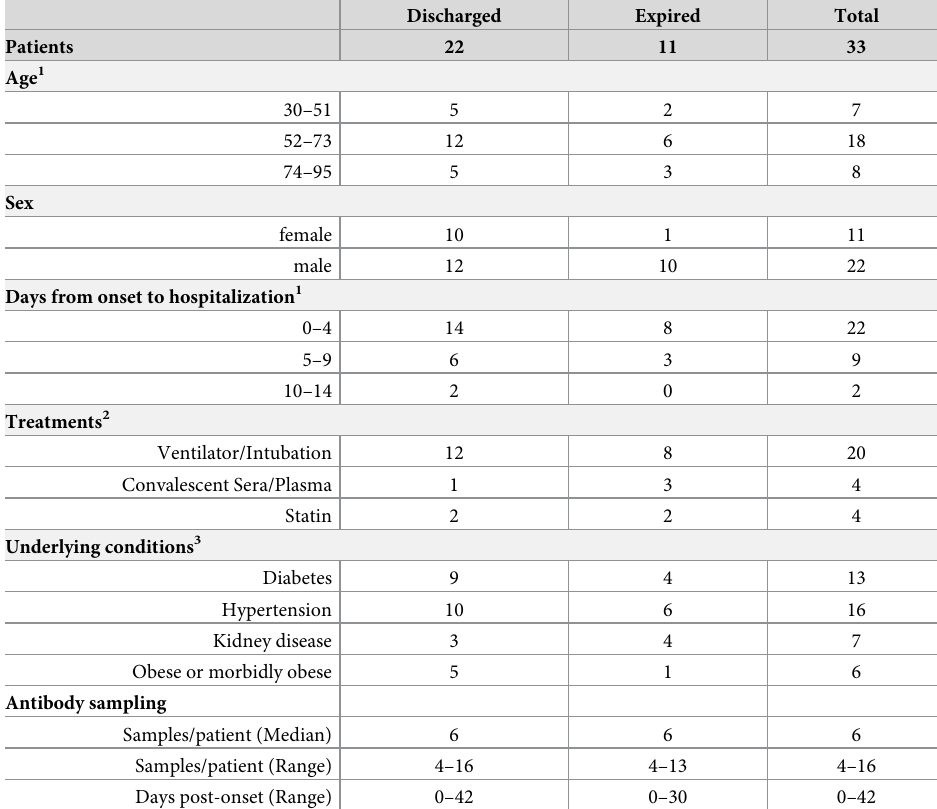
Table 1. Demographics data by patient outcome.